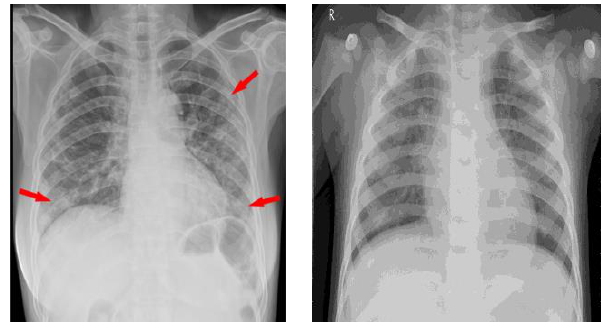
Figure 3 . Chest CT image of a healthy person (right), Chest CT image of a person with COVID-19 with red arrows showing involved areas (left).